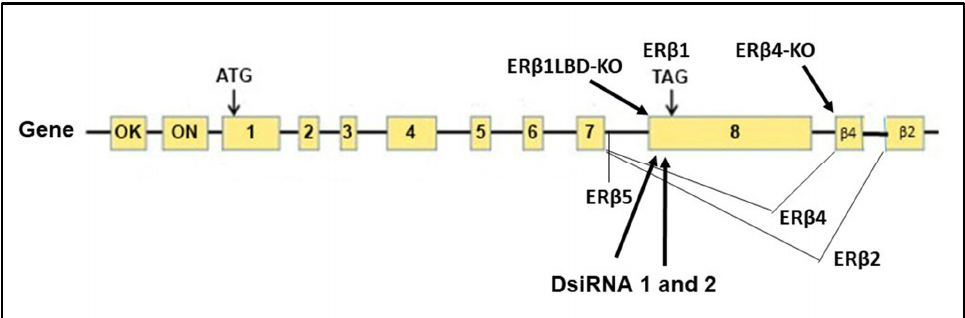
Figure 1. Schematic overview of the ER β gene, two promoters 0 K and 0 N, localization of guideRNA for truncation of ER β 1 LBD, guideRNA for mutation of ER β 4 specific splice site and localization of the two DsiRNA oligos.